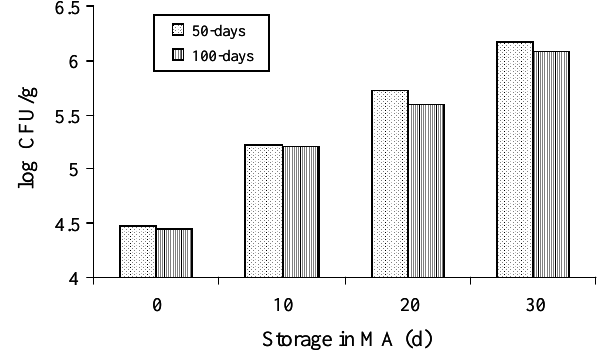
Figure 1. Increase in bacterial counts in lamb